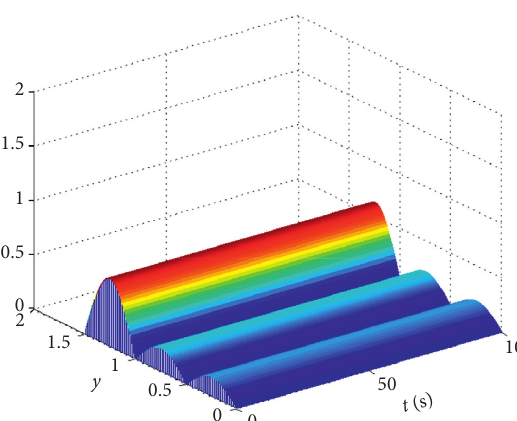
Figure 4: The input signal.